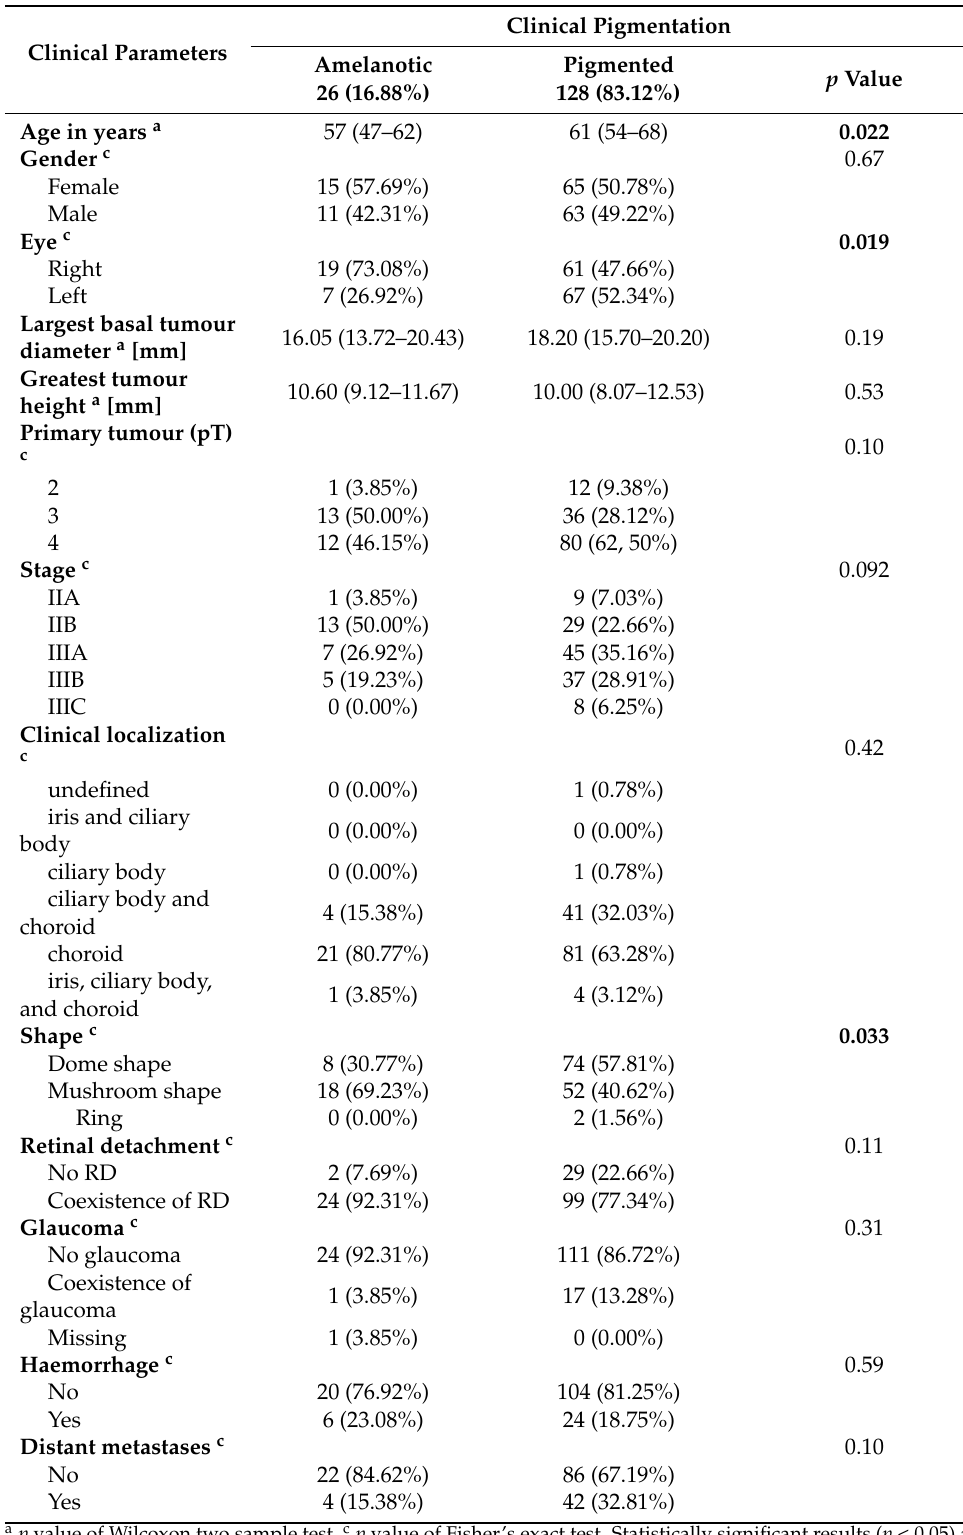
Table 2. Summary statistics for relation between amelanotic and pigmented uveal melanoma and clinical